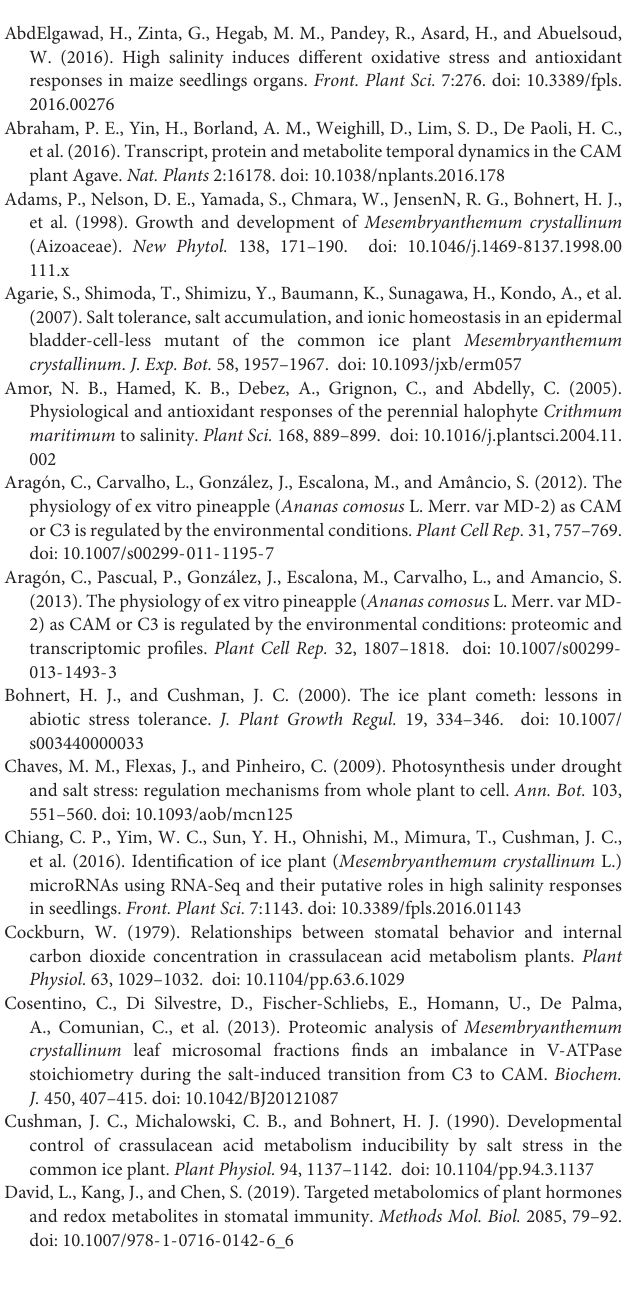
FIGURE S1 | Development of a method for measuring leaf area. (A) Positioning of the plant and 1 cm 2 reference spot. (B) Original image taken by a digital camera. (C) Border outline of the leaves, as a quality control for the pixel selection.